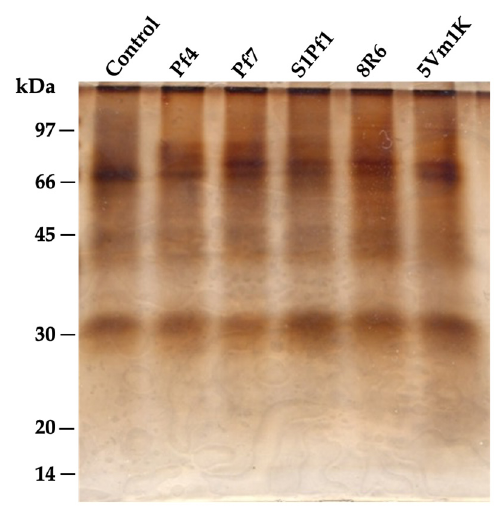
Figure 6. SDS-PAGE analysis of total proteins extracted from onions inoculated or not (Control) with